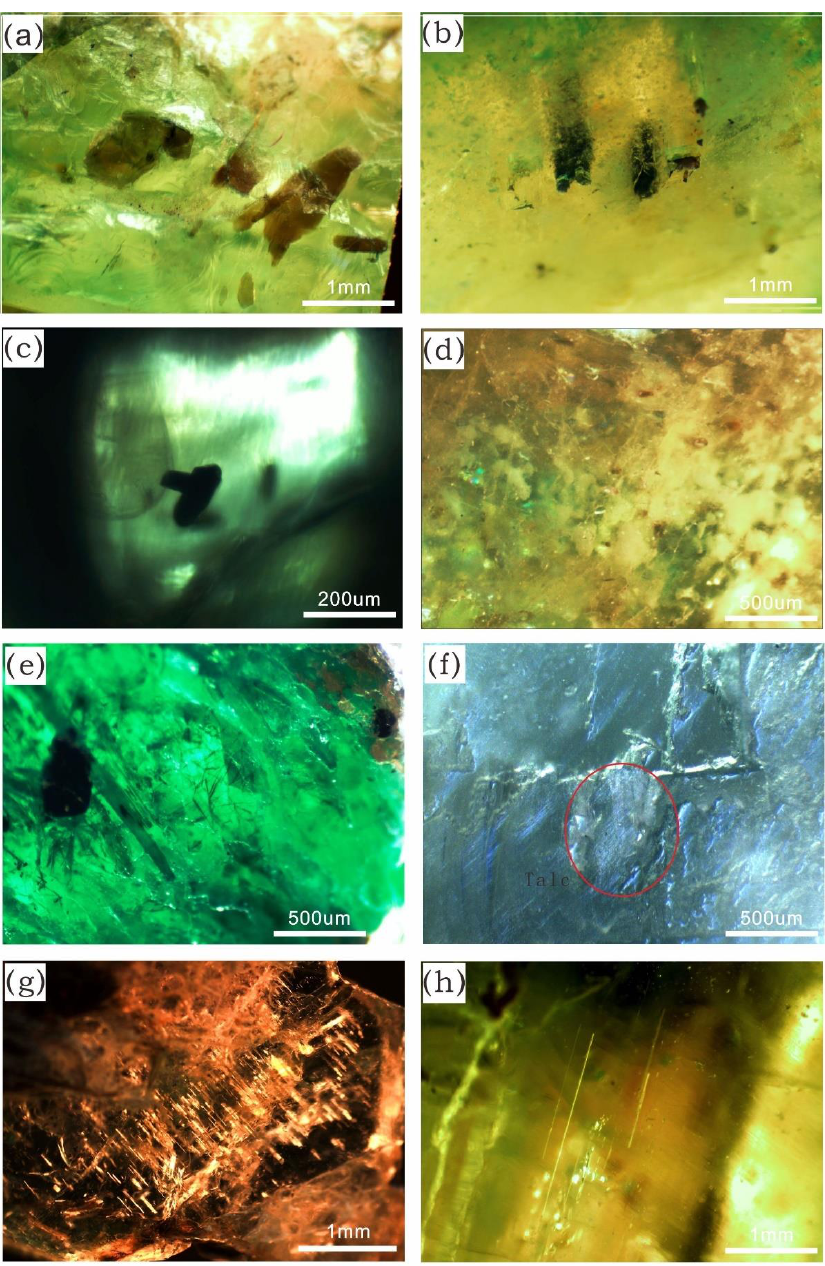
Figure 5. ( a ) Platelets of phlogopite were widespread in the Indian emerald samples; ( b ) Long columnar black quartz was observed in sample 94-6; ( c ) Short columnar black mineral was present in sample 94-8; ( d ) White cloud solid inclusion was observed in sample 127-9; ( e ) Sample 127-2 contains black inclusions and disorderly distributed acicular inclusions; ( f ) Talc mineral was identified in sample 94-5; ( g ) Cloud of tubes form a rain-like inclusion parallel to the c-axis in sample 94-8; and ( h ) A group of parallel needle-like inclusions were seen in sample 127-10.